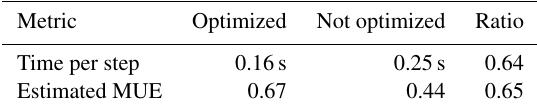
Table 2. Data transfer cost estimations of the dynamical core for a theoretical lower bound (METIS), dynamical core implementation using the STELLA library (COSMO), and non-optimized dynami- cal core implementation (no-merging).